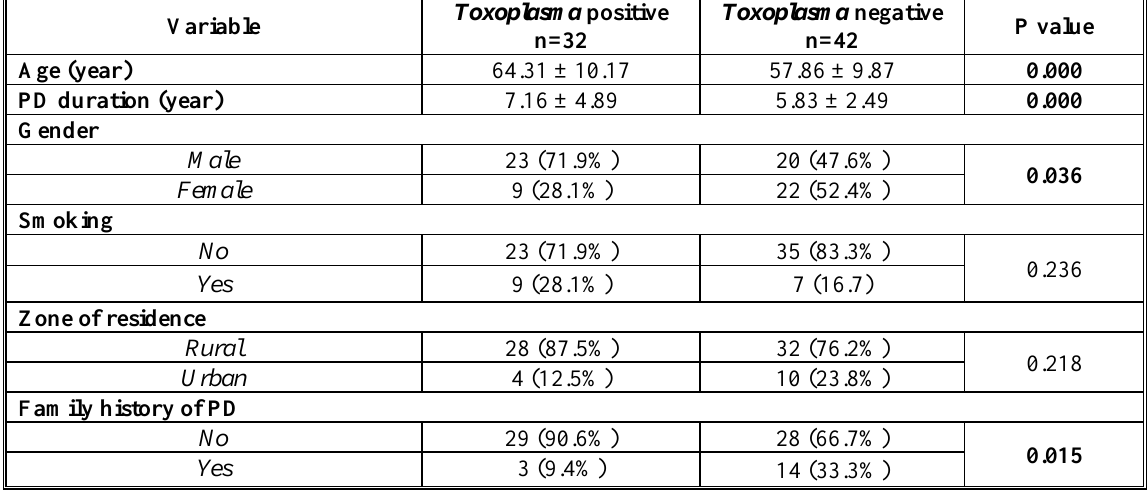
Table 3. Patients’ characteristics by prevalence of